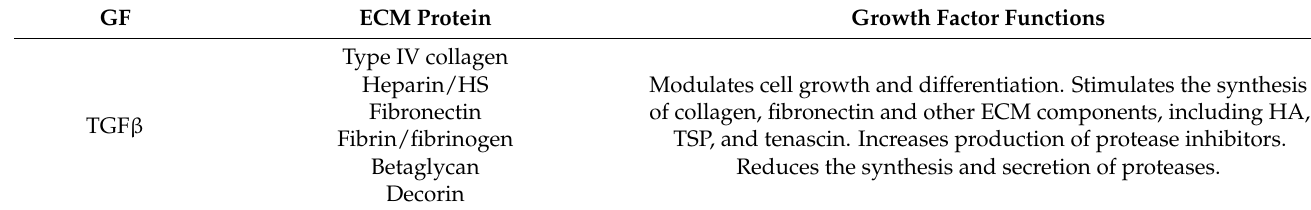
Table 1. Growth factors and their association with ECM proteins. GF ECM Protein Growth Factor